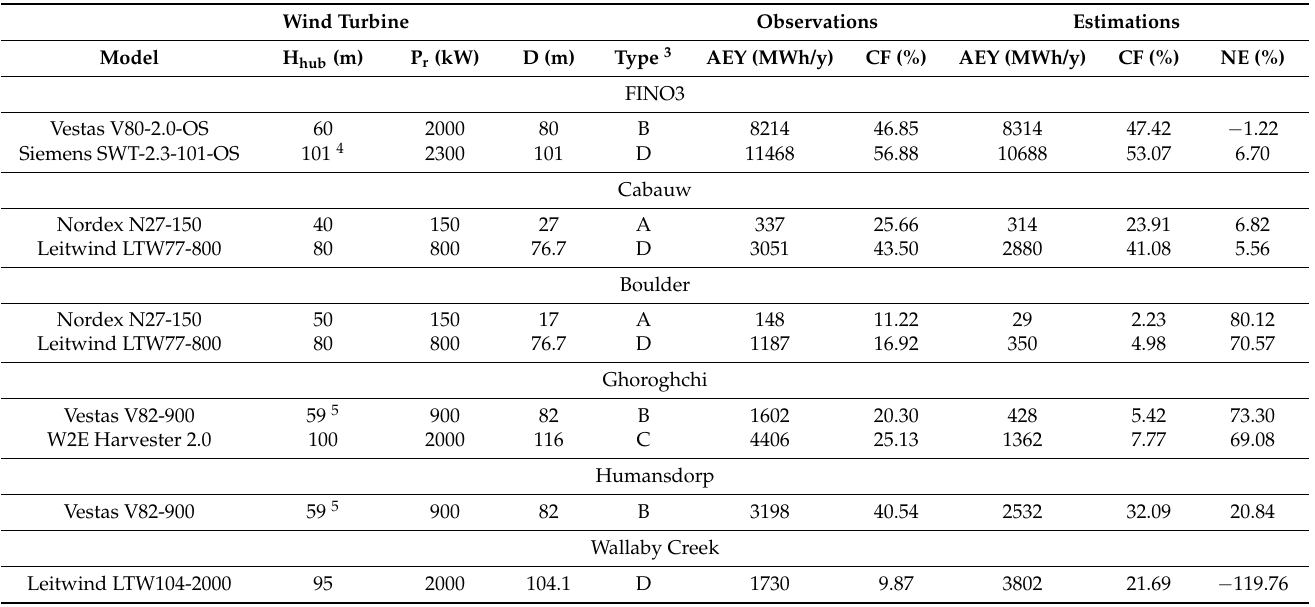
Table 5. Statistical values calculated by wind turbine and hub height of annual energy production observed vs. estimated by ERA5 at the six towers 1,2